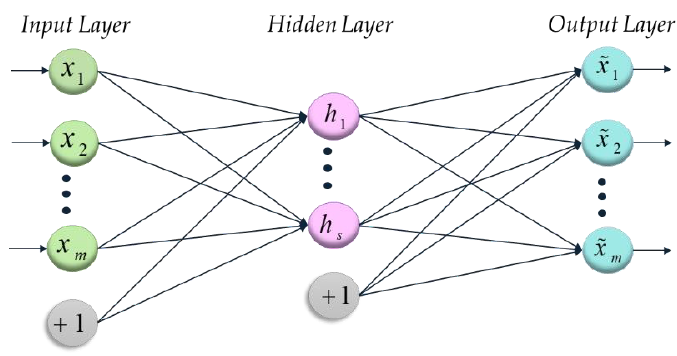
Figure 1. The structure of a standard autoencoder with a single hidden layer.